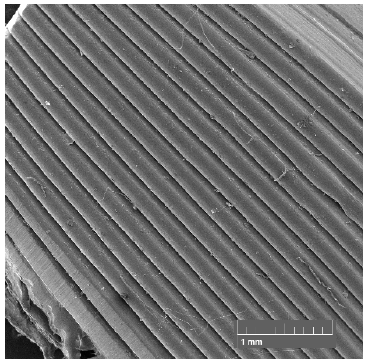
Figure 15. SEM micrographs of the 3D-printed static mixer for the PET-G 3T 0C sample at ( a ) 50×, ( b ) 200× and ( c ) 2000× magnification .